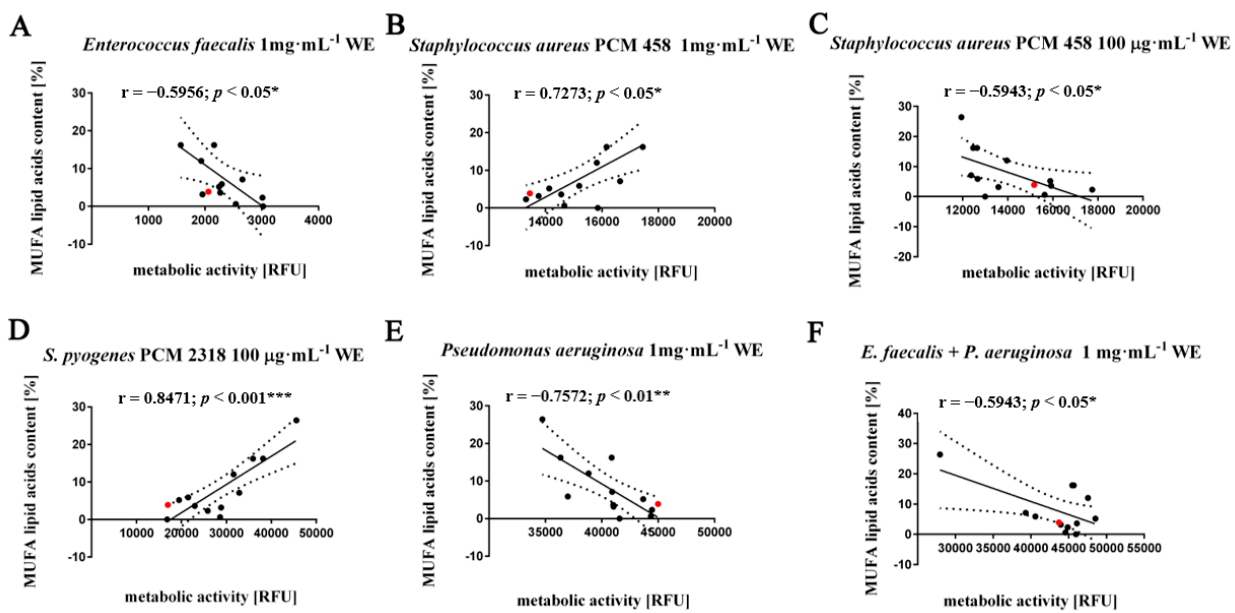
Figure 5. Effect of monounsaturated fatty acid (MUFA) ( A – F ) on the metabolic activity of selected bacterial species: Enterococcus faecalis , Staphylococcus aureus PCM 458, Streptococcus pyogenes PCM 2318, Pseudomonas aeruginosa , mixed two species culture— Enterococcus faecalis and Pseudomonas aeruginosa . Twelve water or ethanol extracts with defined concentrations of 1 mg · mL − 1 , 100 µ g · mL − 1 and 10 µ g · mL − 1 (black dots) were considered. WT cells are marked with a red dot. Results represent the mean from three independent experiments. The 95% confidence interval is shown. Correlation analysis of the data was performed using a Linear Correlation (Pearson r) test.